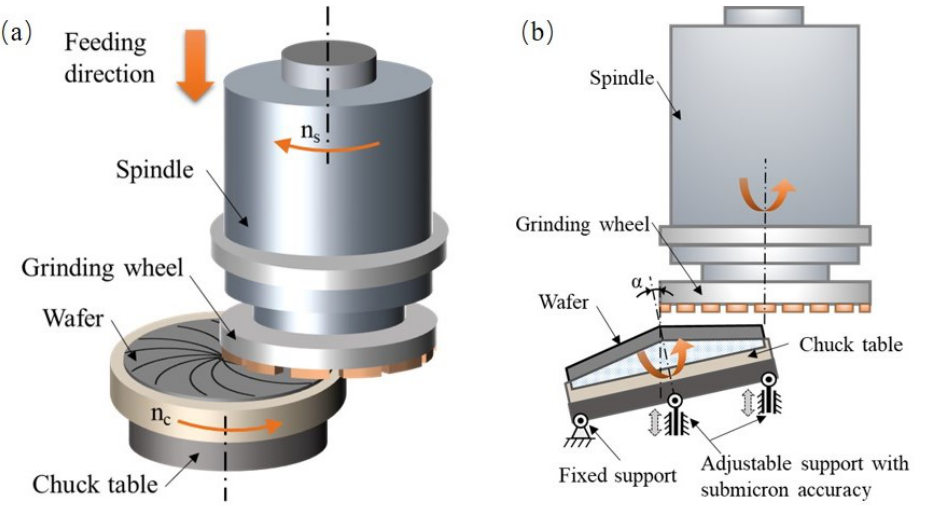
Figure 1. Illustration of wafer backside grinding. ( a ) Diagram of in-feeding mode grinding. ( b ) Principle of inclination angle adjustment for TTV control.